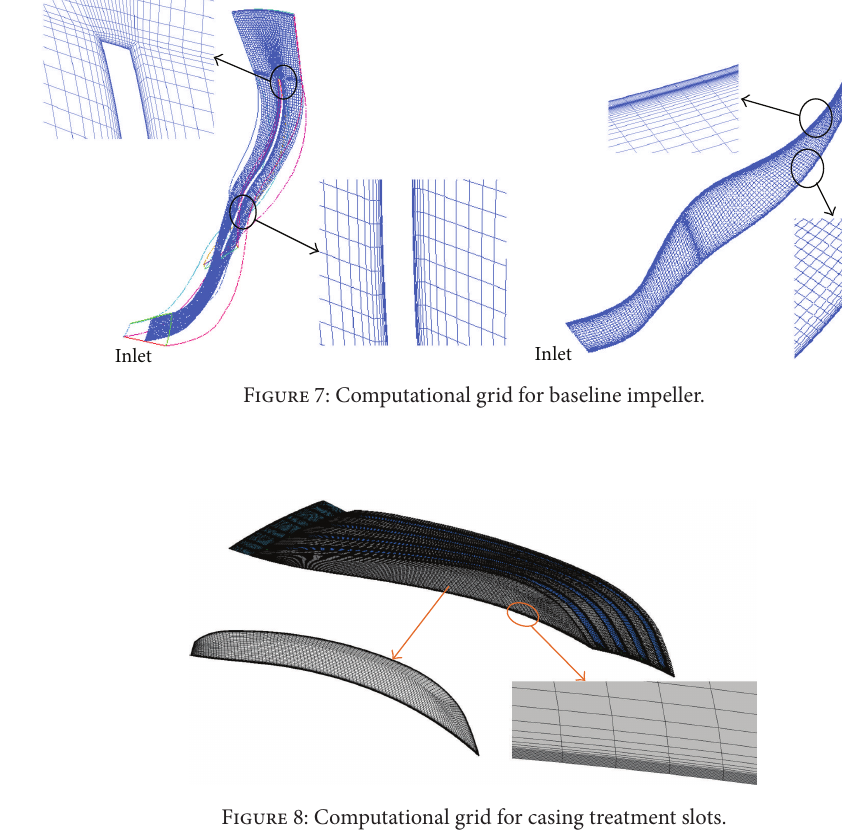
Figure 8: Computational grid for casing treatment